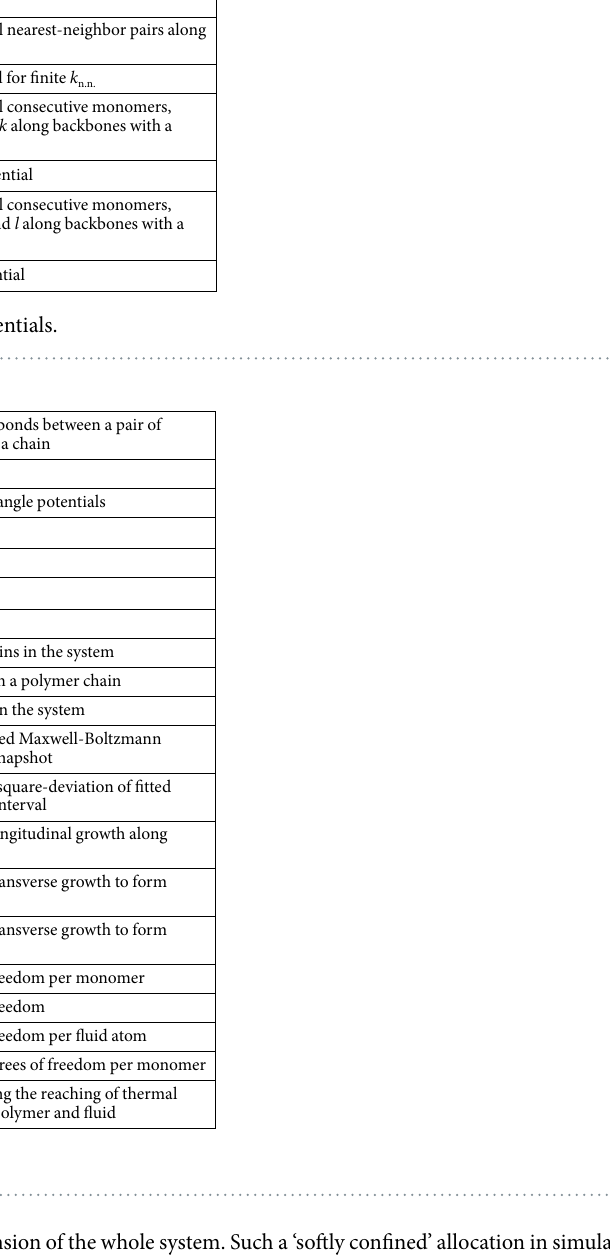
be much smaller than the dimension of the whole system. Such a ‘softly confined’ allocation in simulation, on the other hand, reflects certain features encountered in confined biological environments. Note that the analysis carried out in Fig. 3 takes data from very short periods because of temperature varia- tions for simulated systems under no thermal controls, in contrast to those in Figs 2(a) and 4, where the quan- tities are derived from direction vectors. The latter vectors carry no direct dependence on temperature and a time period of 125 times of that in Fig. 3 to take averages for each curve. The intervals for Fig. 2(a) are (chosen arbitrarily) from the quasi-steady situations starting at t = 29.4 (for s = 0), t = 42.15 (for s = 1), t = 41.9 (for s = 2), t = 41.65 (for s = 3), t = 59.65 (for s = 4) and t = 169.2 (for s = ∞ ) respectively, of Fig. 4 in ref. 52. R-parameters. We define the parameter 48, 49